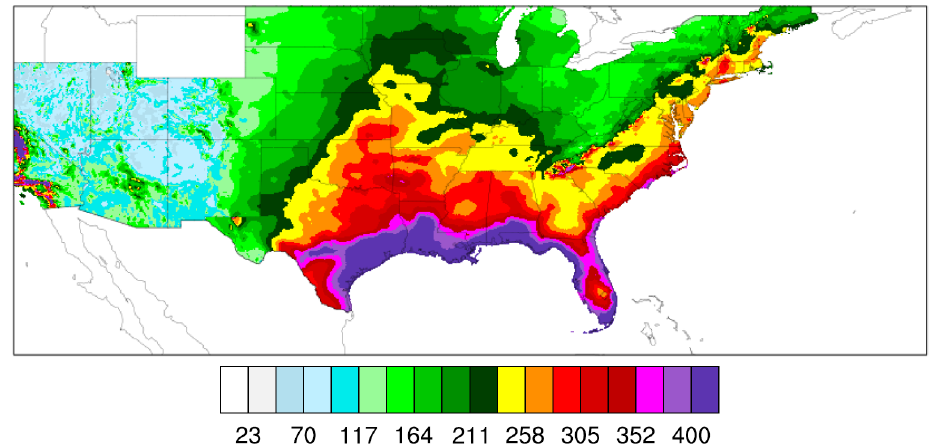
Figure 4. National Oceanic and Atmospheric Administration (NOAA) Atlas 14 100-yr, 72-h precipitation depth (mm) threshold field (for all U.S. states except the northwestern